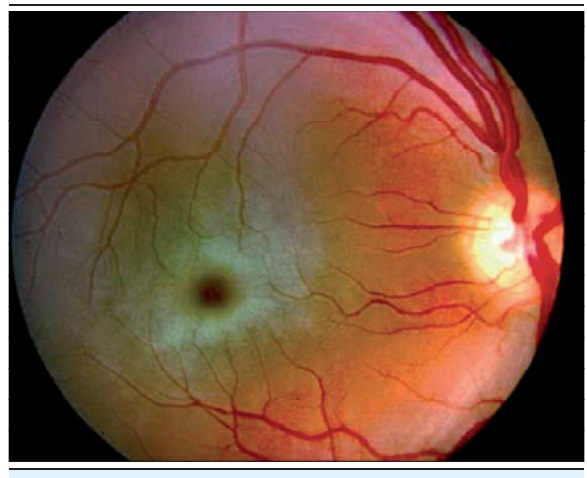
Figure 2 . Macular cherry red spot observed under